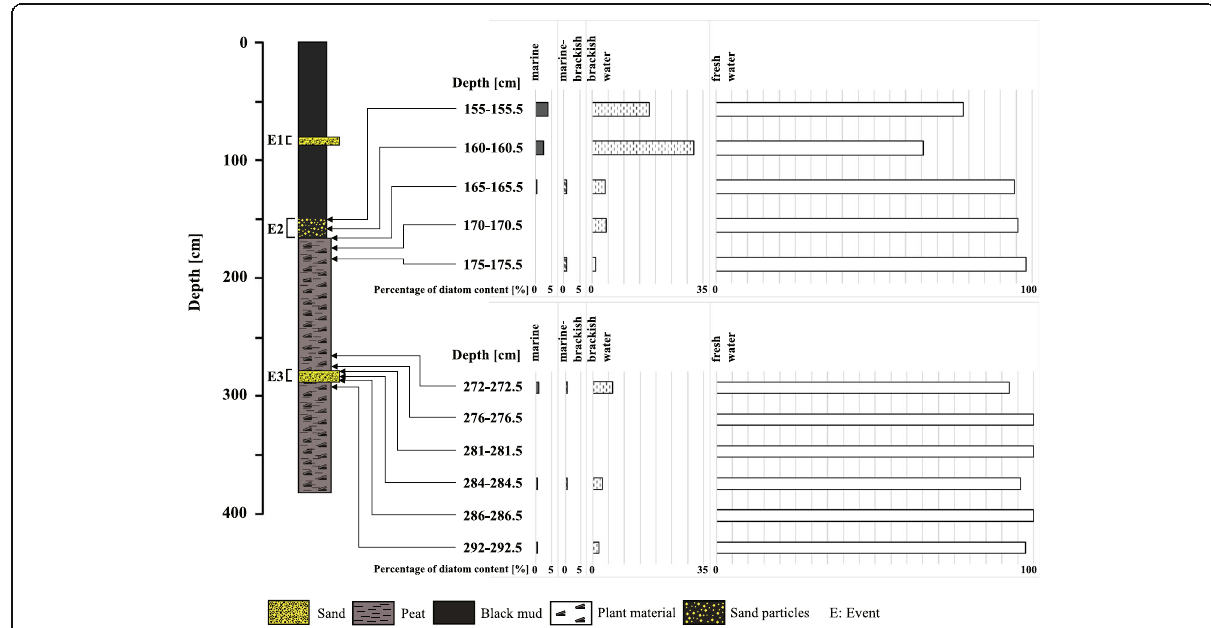
Fig. 5 Relative abundance of diatom assemblages (%) near the event horizons classified into four salinity groups: freshwater, freshwater-brackish, brackish-marine, and